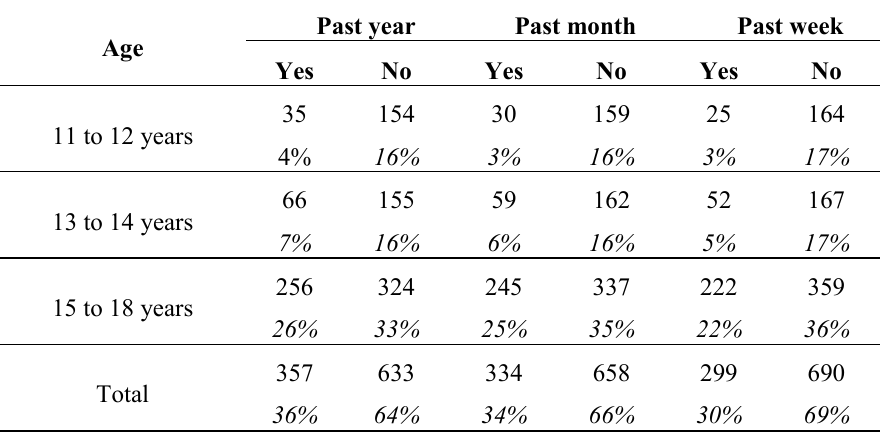
Table 3. Distribution of study participants by waterpipe smoking and age (n =